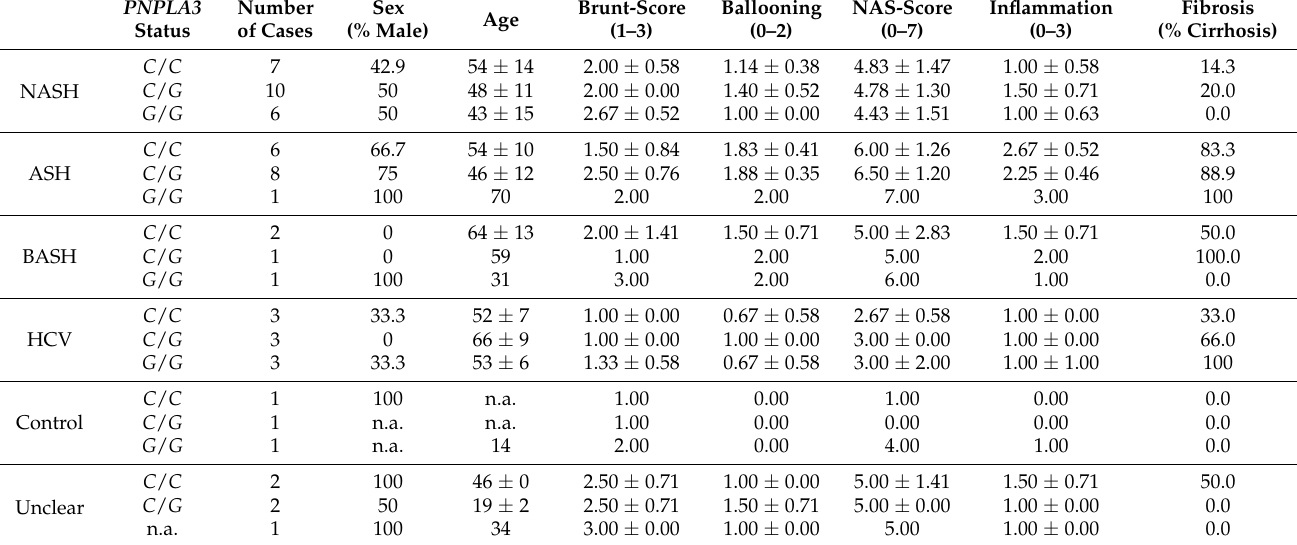
Table 1. Patient